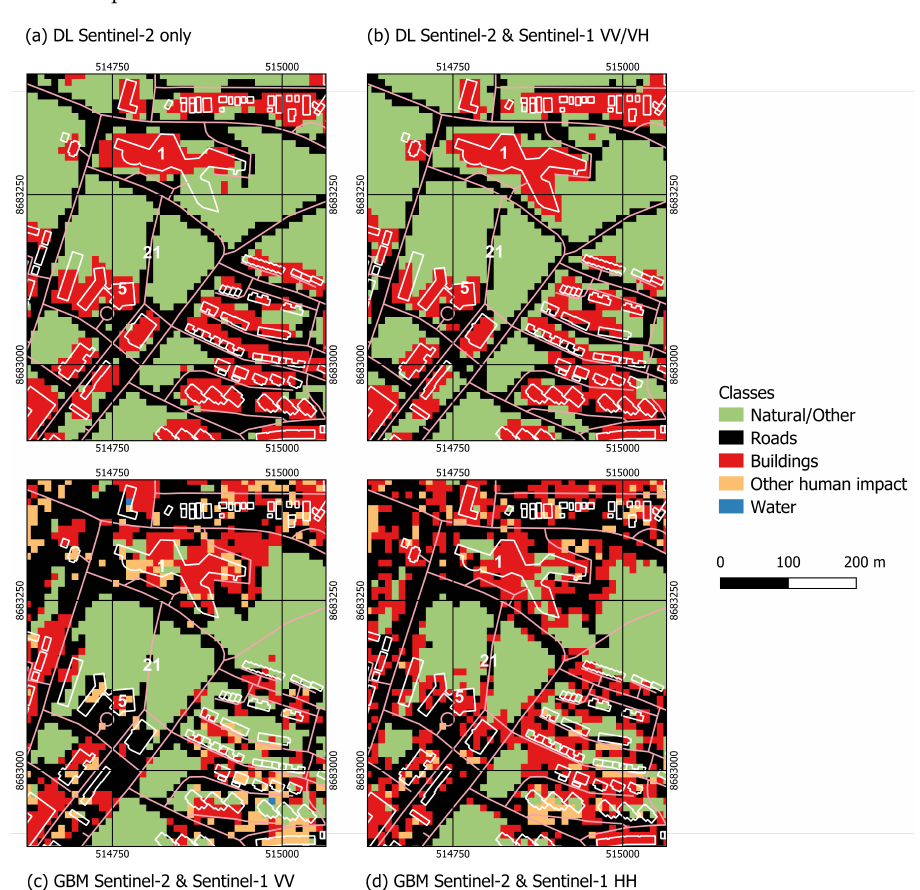
Figure 7. Examples for classification results (Deep Learning (DL) and Gradient Boosting Machines (GBM)) of Longyearbyen, Svalbard, Norway: ( a ) DL based on Sentinel-2 only, ( b ) DL based on Sentinel-2 and Sentinel-1 VV+VH, ( c ) GBM based on Sentinel-2 and Sentinel-1 VV, and ( d ) GBM based on Sentinel-2 and Sentinel-1 HH. Buildings (white lines) and roads (pink lines) vectors from OpenStreetMap. Numbers correspond to object IDs in Lu et al. [54]. See also Figure 2 for photographs and Figure 1 for input data. Projection WGS 84/UTM zone